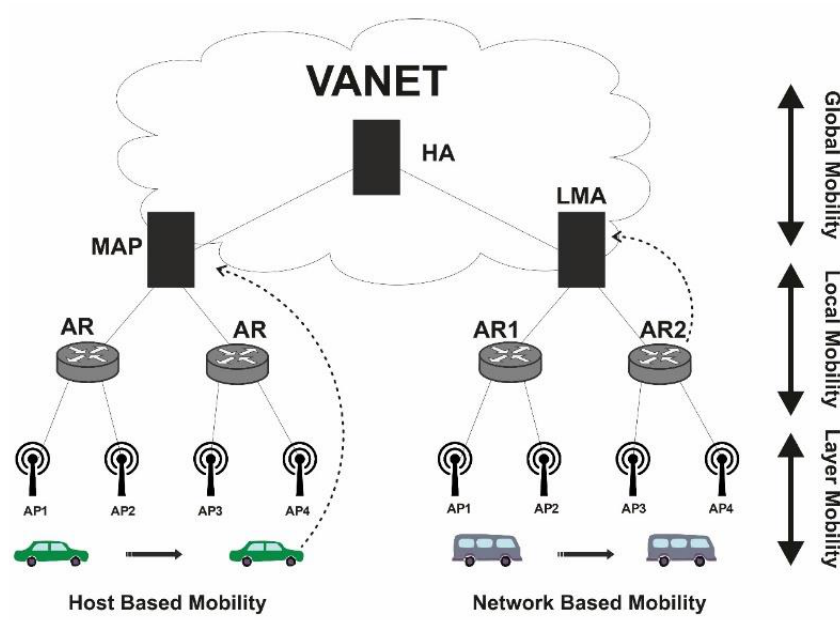
Figure 2. Mobility Classification in Host-based and Network Based.